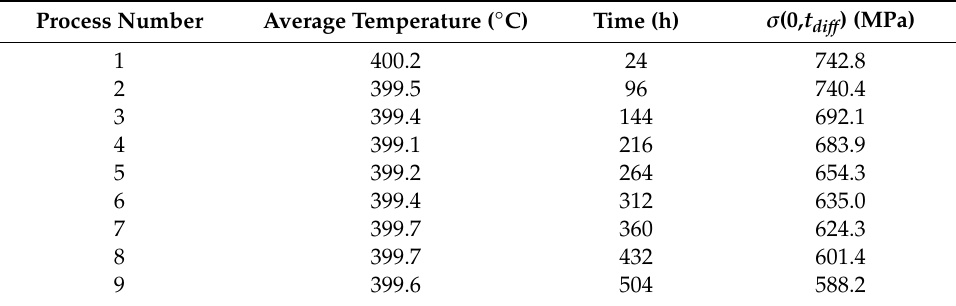
Table 3. The parameters of long-term K + ↔ Na + ion exchange processes in BK7 glass.